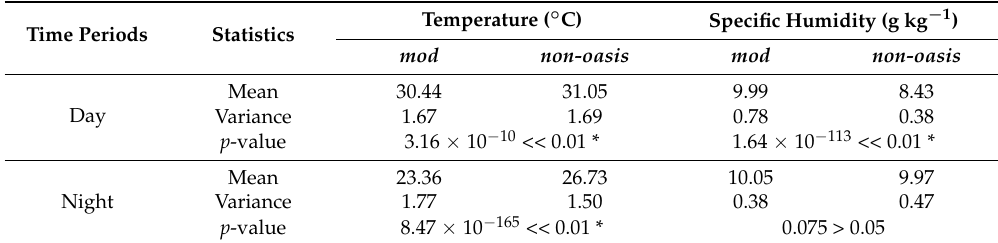
Figure 7. The same as Figure 6 but showing for a vertical cross section of air temperature along the white line shown in Figure 6a. Table 3 . Statistical significance of the differences in temperature and humidity between the mod and non-oasis simulations, as assessed using Student’s t -test.